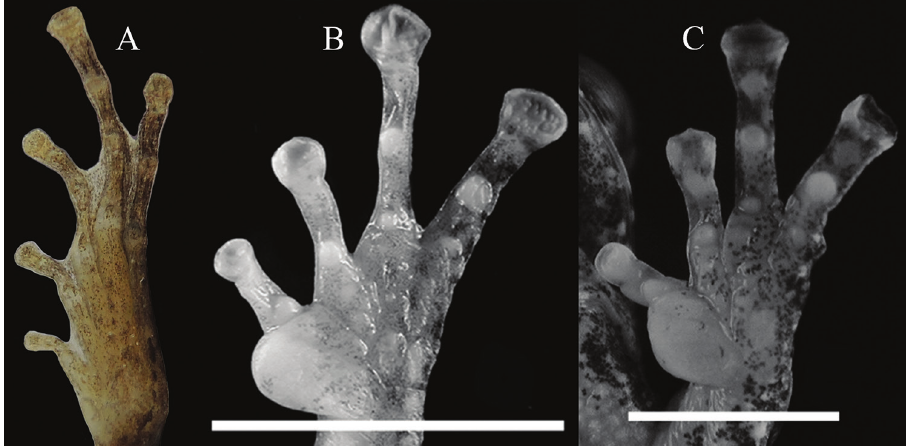
Figure 10. Ventral view of foot of K. idiootocus A and ventral view of hand of K. berylliniris ( B from Wu et al. 2016) and K. wangi ( C from Wu et al.